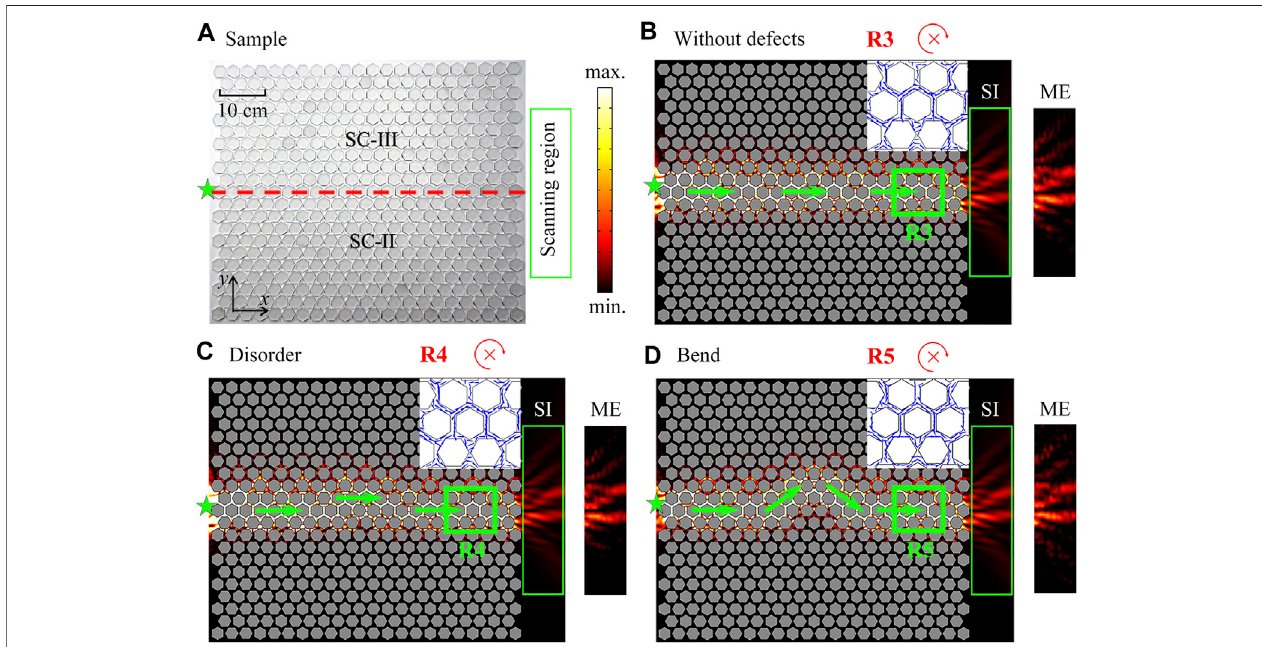
FIGURE 5 | (A) Photograph of an ATI without defects. Green stars and red dashed lines represent the point sound source and domain wall, respectively. Green openrectangleisthescanningregioninthemeasurement.Simulated(SI)andmeasured(ME)distributionsofintensity fi eldintheATIswiththreedifferentcon fi gurationsat 16.0 kHz, corresponding to (B) without defects, with (C) a lattice disorder and (D) a bend around the domain wall. Green arrows are the propagation paths of sound in the ATIs. Blue arrows in the zooms R3-R5 represent direction of energy fl ow.